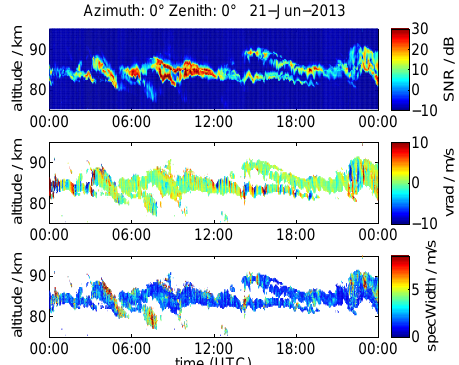
Figure 3. Measured SNR from the vertical beam for 21 June 2013. Radial velocity determined from spectral analysis using a truncated Gaussian fit. Computed spectral width for the vertical